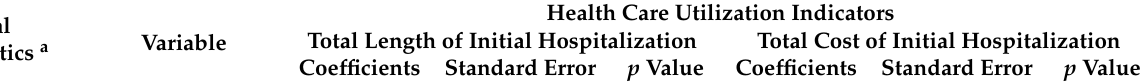
Table 4. Stratified analysis: multiple regression analyses with GEE models for influence of July and weekend admissions on health care utilization indicators in patients with stroke receiving treatments at hospitals with different